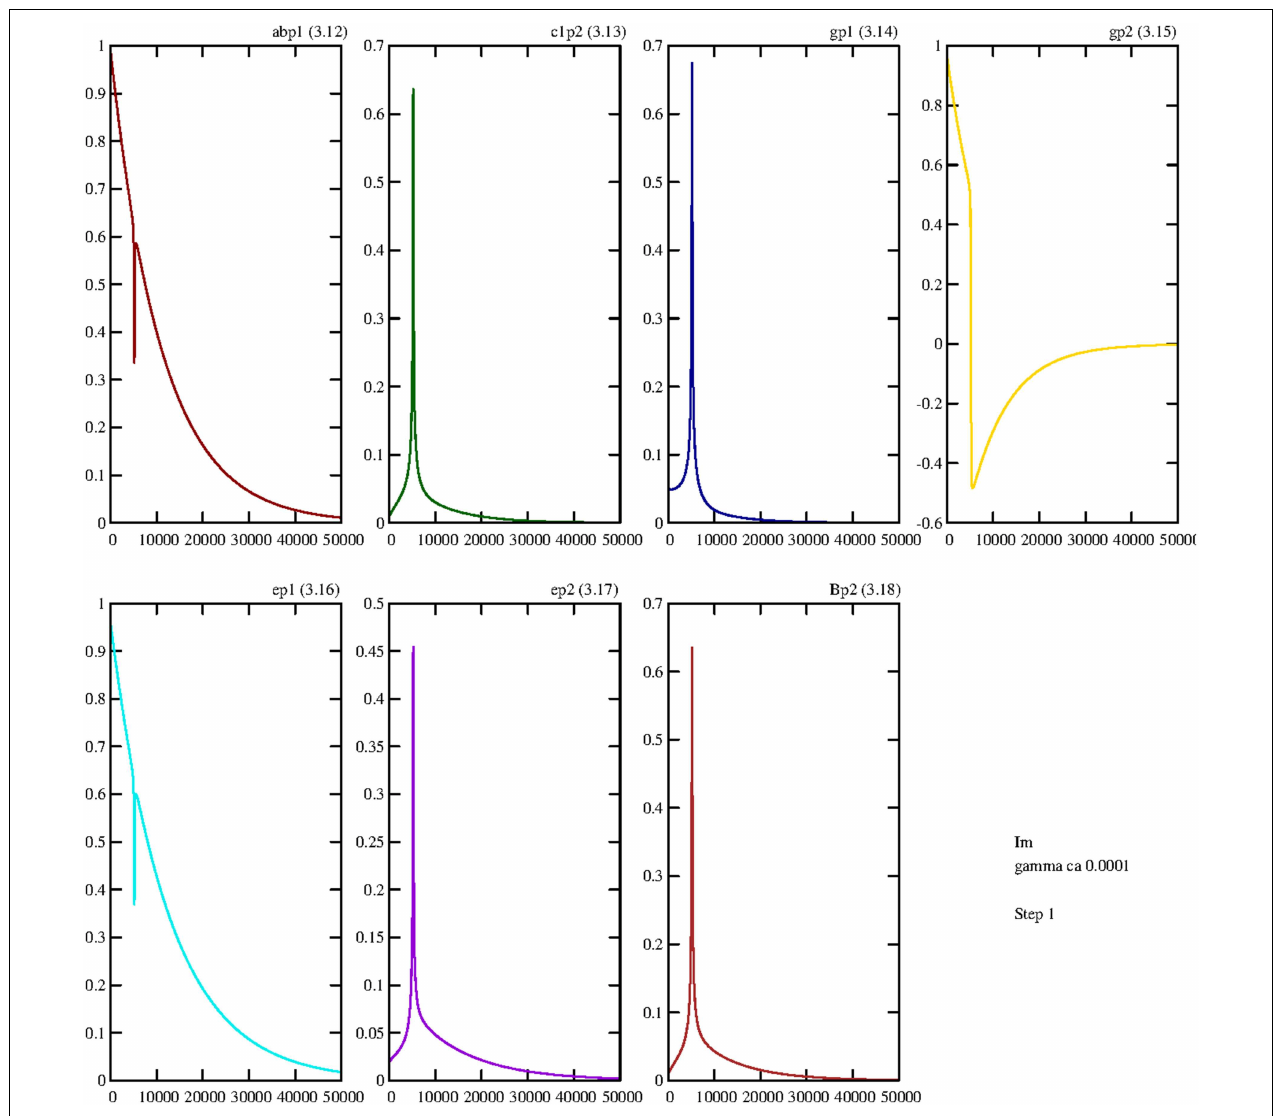
FIGURE 5 | Damped temporal curves representing the real parts of the following operators of the first step: abp 1 = r † l